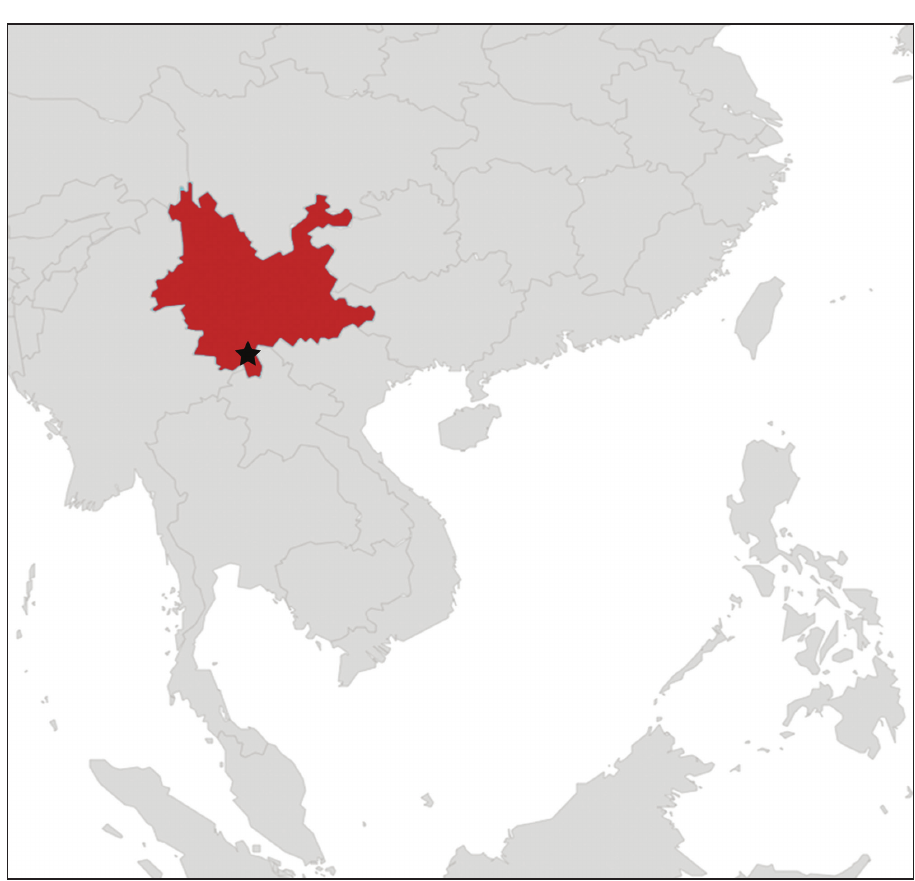
Figure 5. Map of South East Asia showing the type locality of A. yangi sp. n. (black star), red indicates Yunnan Province,